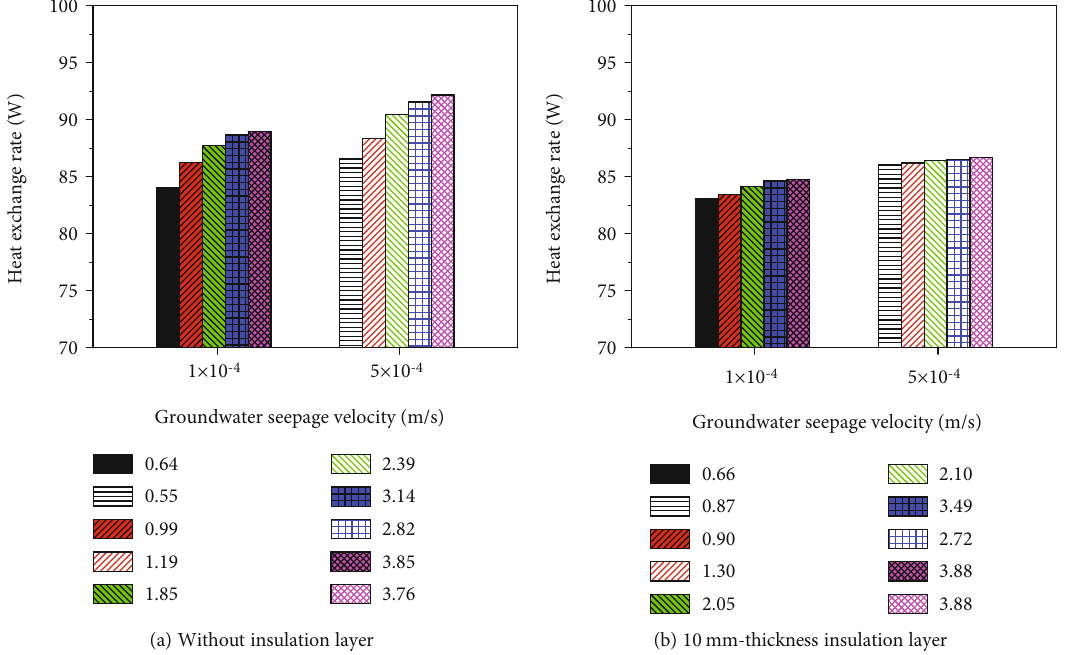
Figure 11: Relationship between heat exchange rate and groundwater seepage velocity at various wind